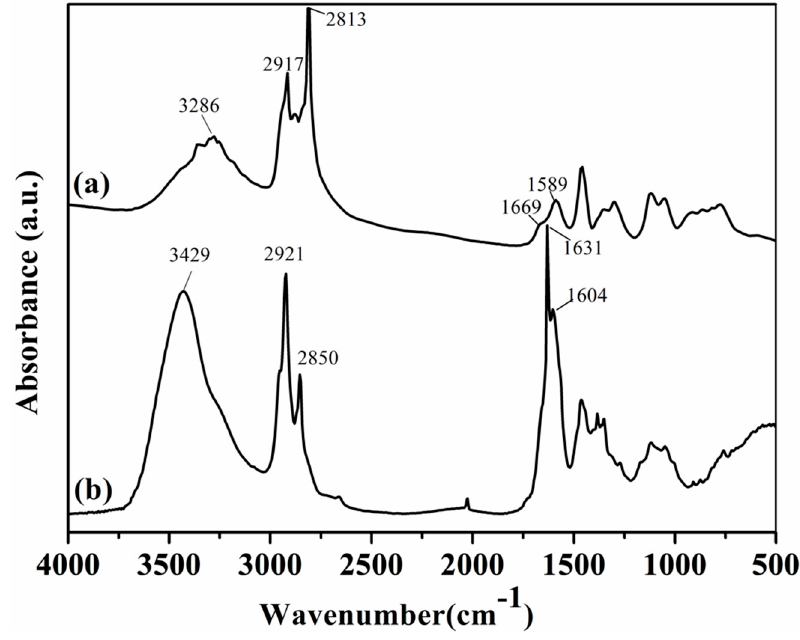
Figure 5. FT-IR spectra of ( a ) neat HPEI and ( b ) ZnO 1:2 /HPEI-10 nanocomposites.